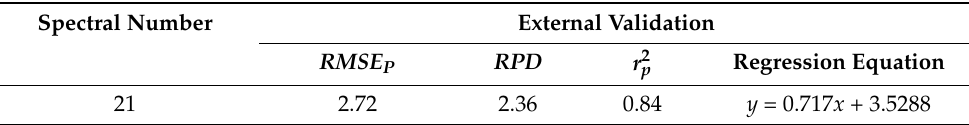
Table 6. External validation of the established PLS models based on de-aromatic wine for Rose Oxide ( µ g/L) in real